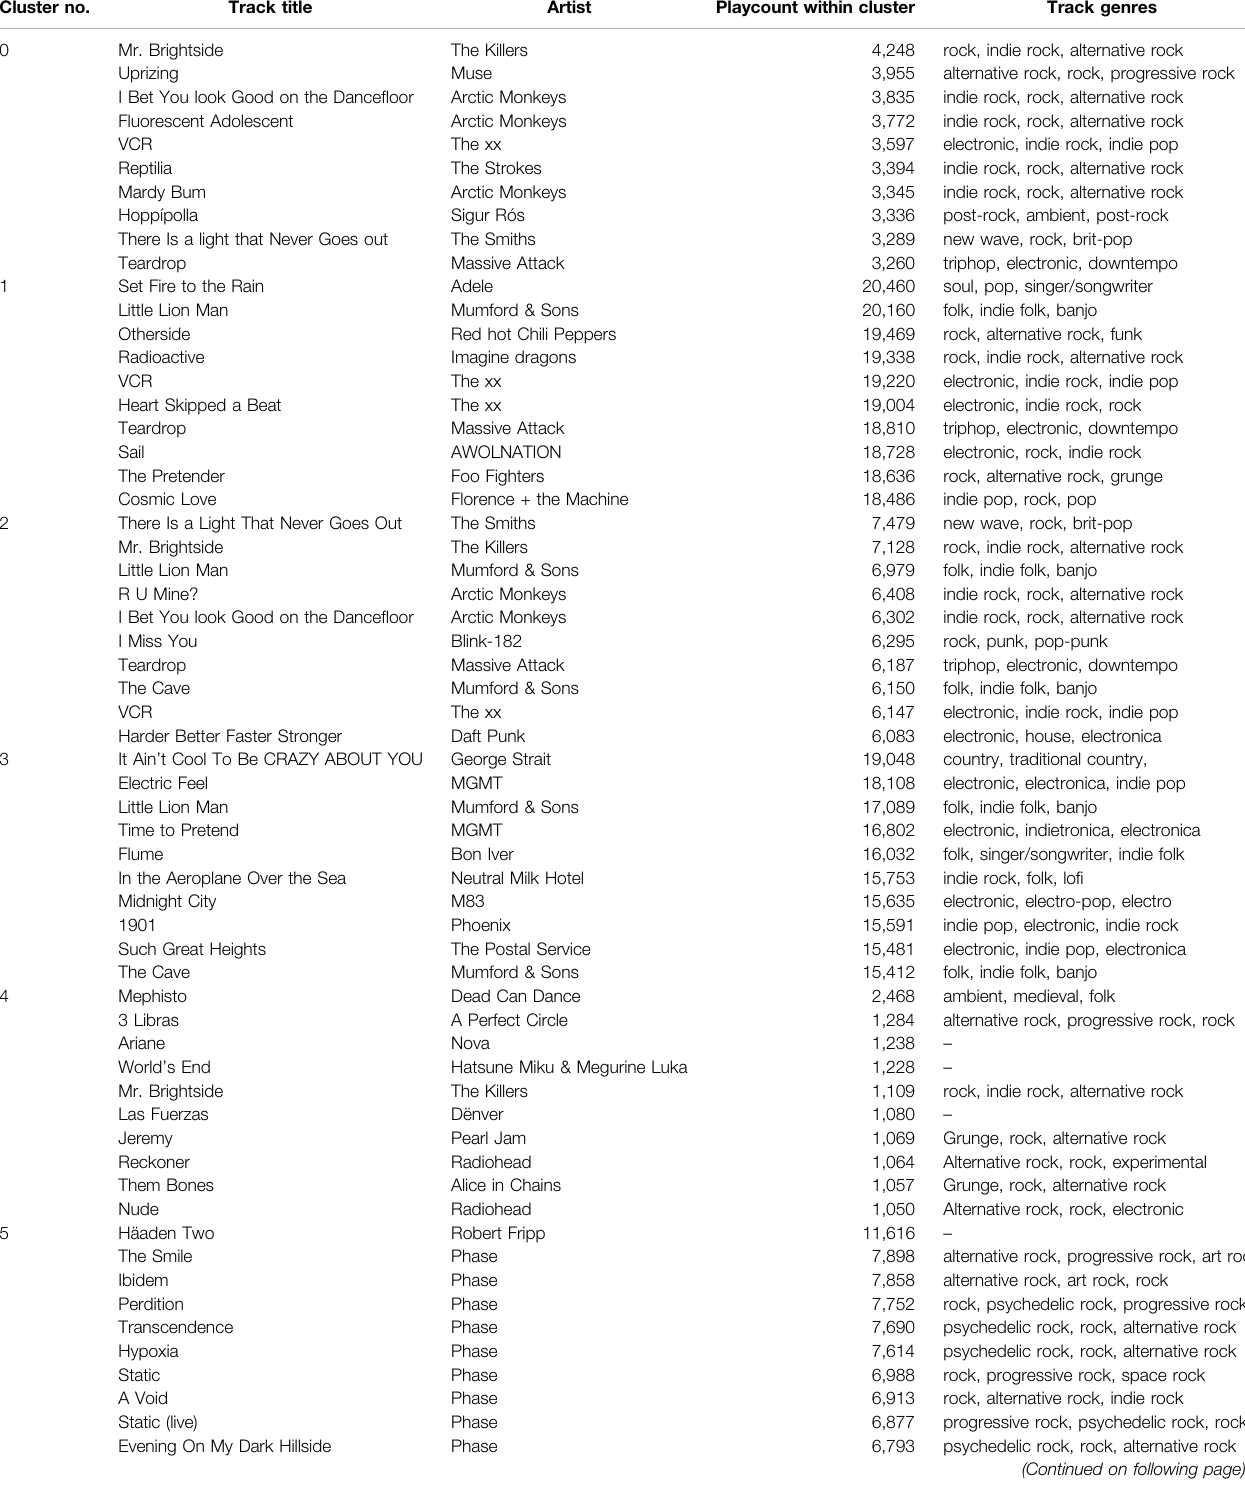
TABLE 2 | The 10 most popular tracks per cluster. Playcount refers to the total number of listening events by the users in each cluster. Cluster